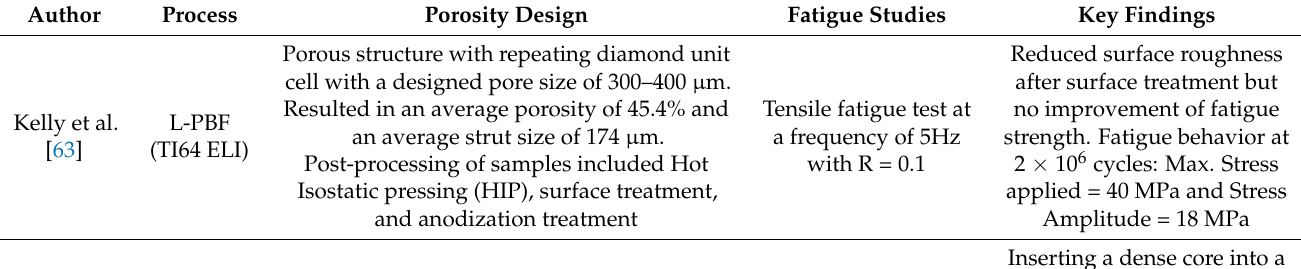
Table 4. Fatigue Behavior of Porous Ti64